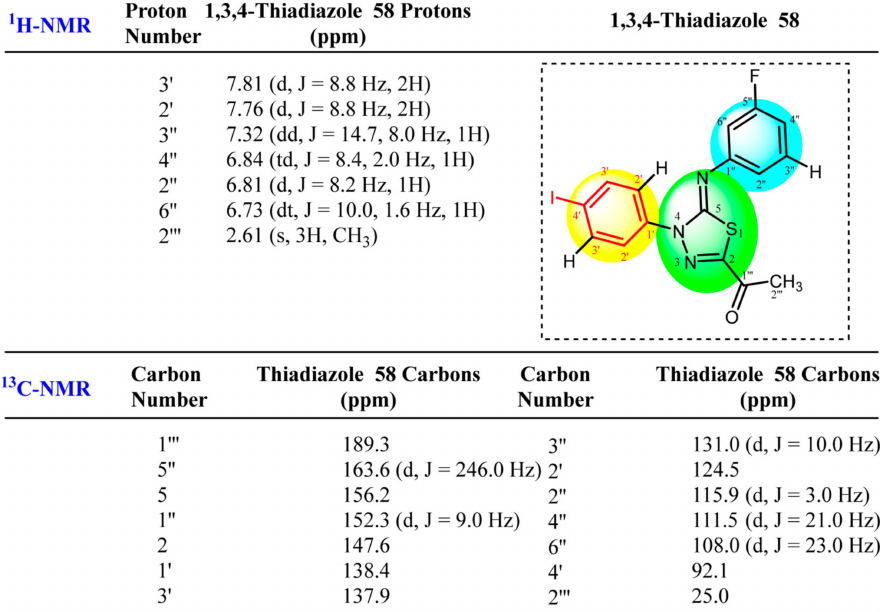
Figure 6. Assigned 1 H- and 13 C-NMR chemical shifts of 1,3,4-thiadiazole 58 .